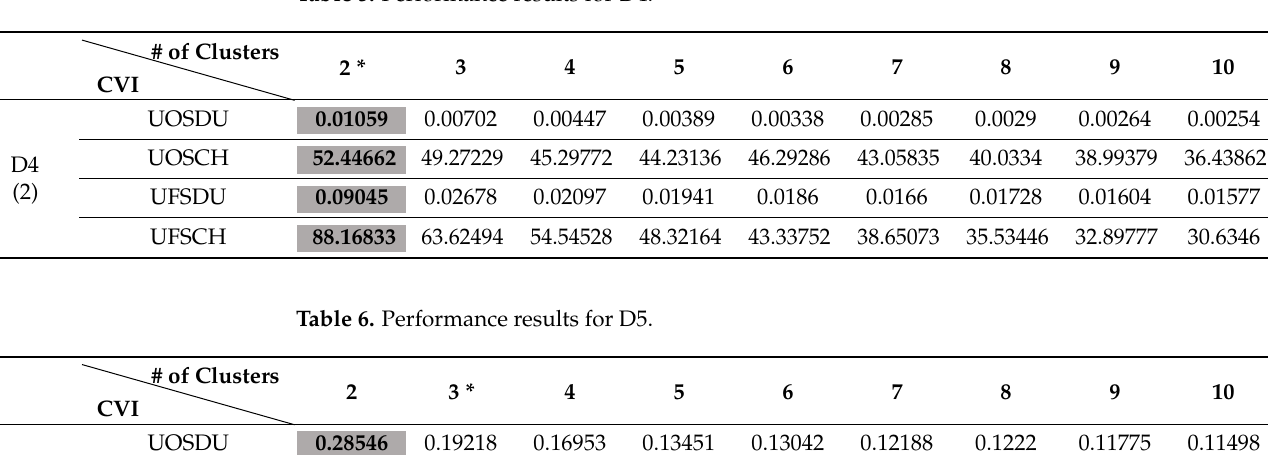
Table 5. Performance results for D4.